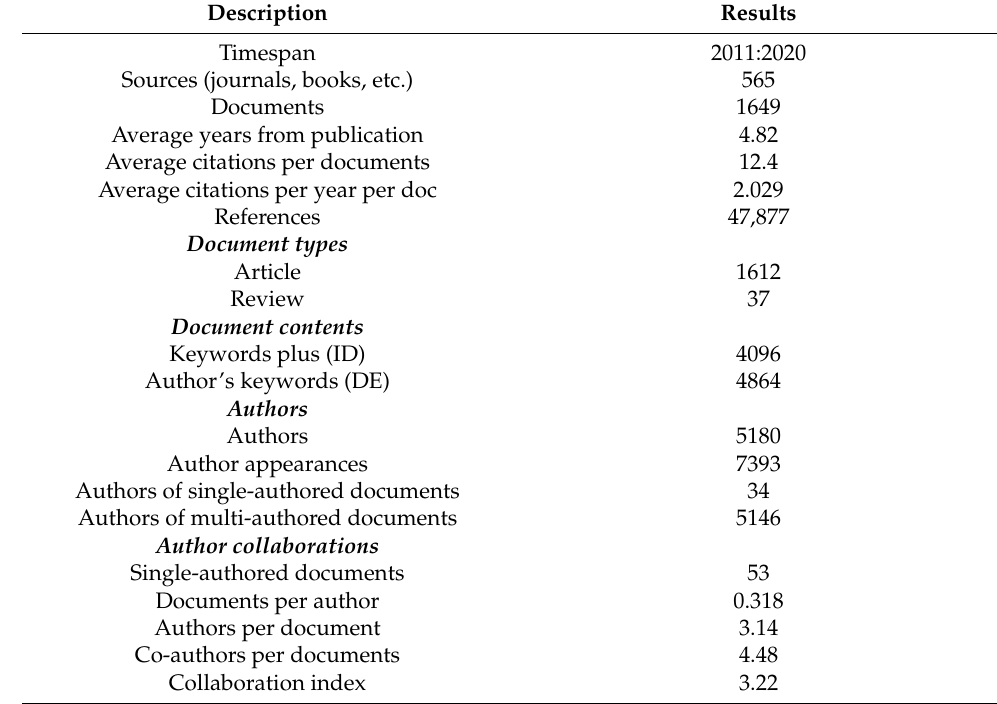
Table 1. Main information of global amaranth-related research from 2011 to 2020.